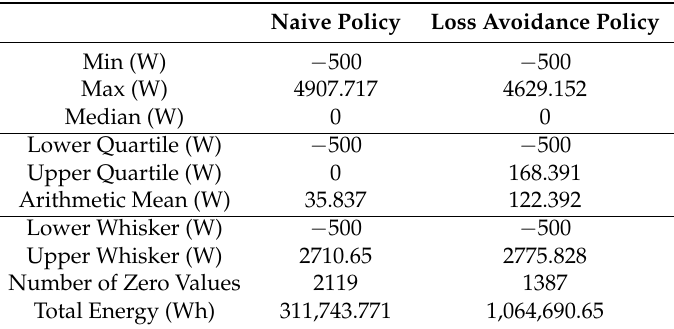
Figure 7. Obtained results for charging ESS. Table 6. Obtained statistical values of Figure 7.